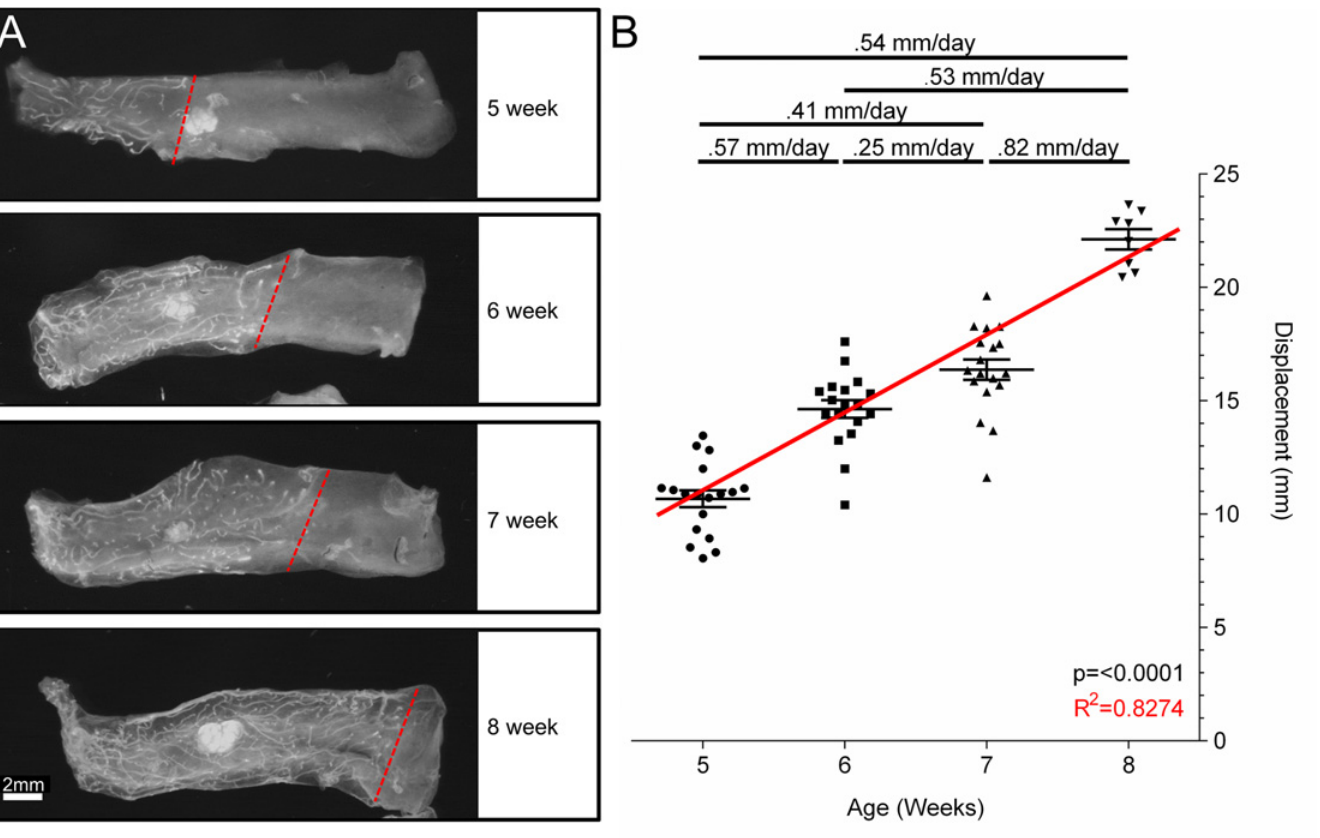
Fig 5. Experimental determination of TEB displacement rate. Quantification of the distance from the nipple to the ductal boundary in 5 (n = 18), 6 (n = 18), 7 (n = 18), and 8 (n = 8) week FVB mice. A) Representative inguinal glands from 5, 6, 7 and 8 week old FVB mice are pictured with a dashed line demarcating the ductal front. B) Quantification of the outgrowths at each time point are fitted with a best fit line (one-way ANOVA p < 0.0001, R2 = .8274). On average during puberty, the duct grows at a rate of 0.54 mm per